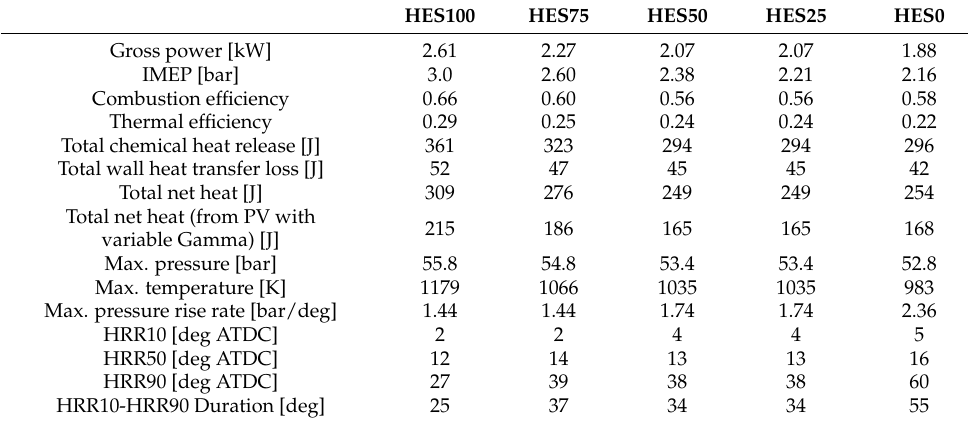
Table 10. Engine summary for the different HES cases.